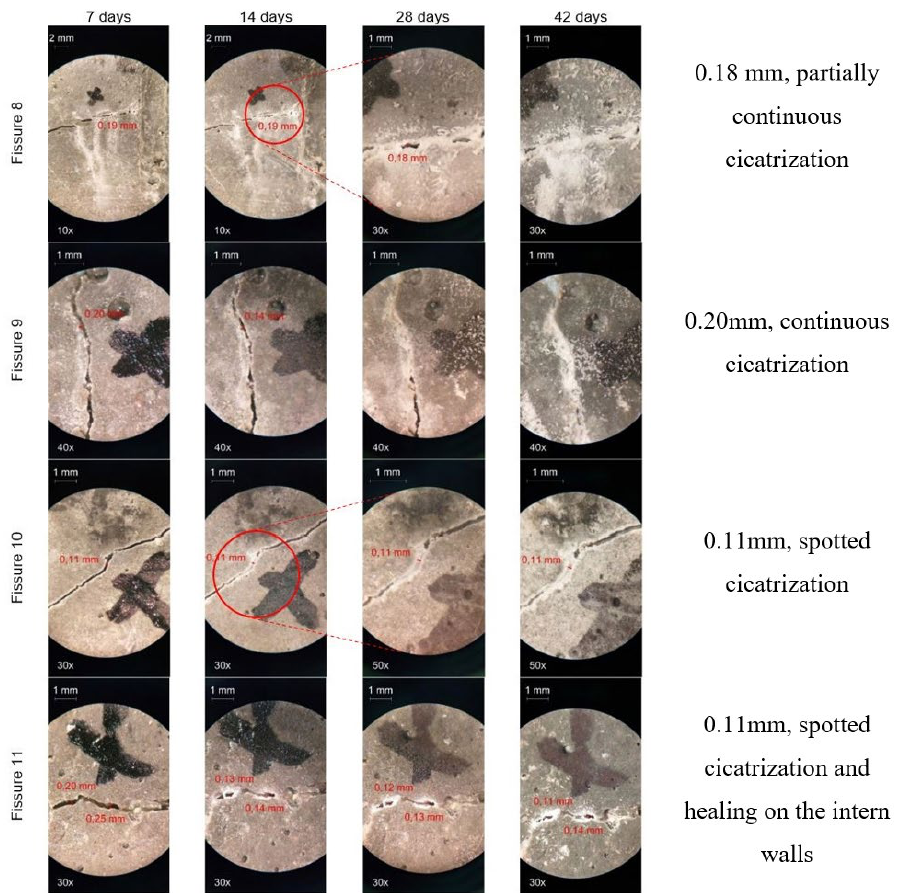
Figure 10 – Self-healing activity of sample BAC.8 at several ages